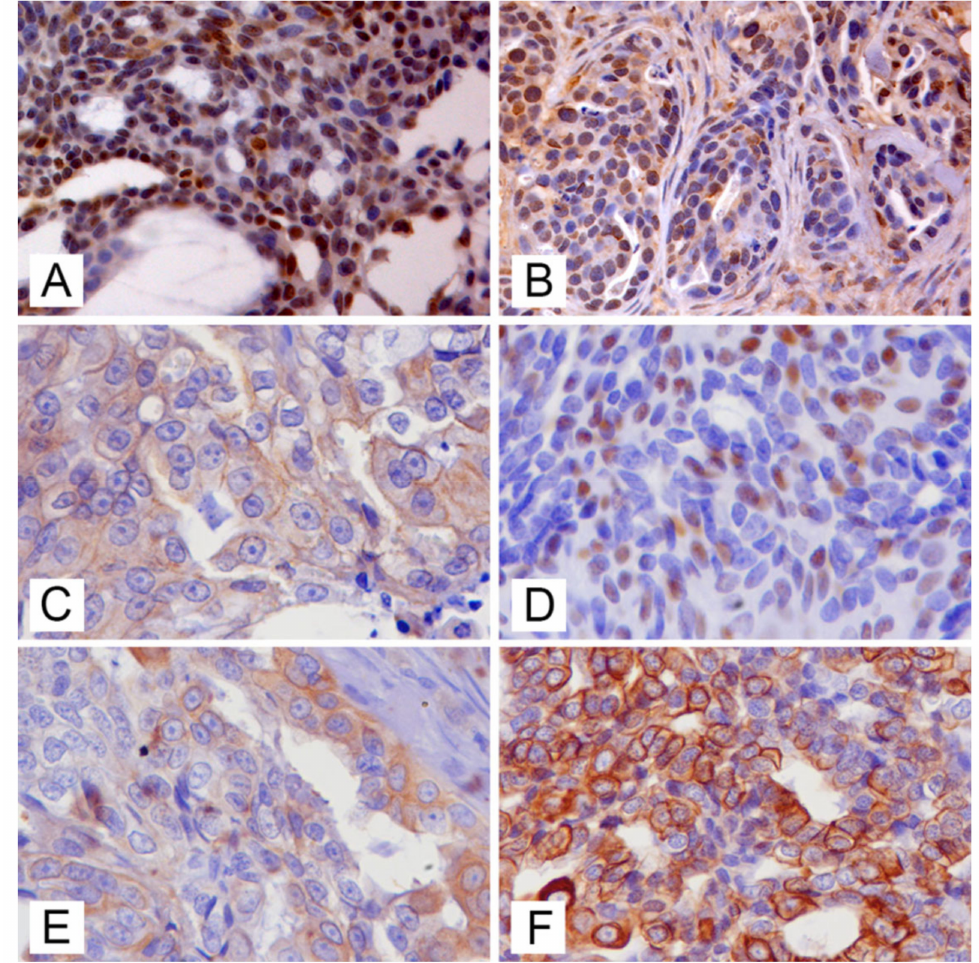
Figure 4. Feline mammary carcinomas (FMCs), immunohistochemistry for molecular phe- notyping: ( A ) nuclear labelling for anti-oestrogen receptor (OR) antibody in a OR+ FMC (bar = 50 µ m); ( B ) positive nuclear labelling for anti-progesterone receptor (PR) antibody in a PR+ FMC ((bar = 50 µ m); ( C ) immunolabelling of membrane for anti-c-erbB2 antibody in a 2+ c-erbB2 FMC (bar = 50 µ m); ( D ) nuclear immunolabelling for anti-p63 antibody in a p63+ FMC (bar = 50 µ m); ( E ) cytoplasmic immunolabelling for anti-cytokeratin (CK) 5/6 in a CK5/6+ FMC (bar = 50 µ m); ( F ) cytoplasmic immunolabelling for anti-CK14 in a CK14+ FMC (bar = 50 µ m). Following the semi-quantitative scoring system and the algorithm for molecular classification, 51 tumours (50%) were classified as luminal-like, 44 as basal-like (43%), 7 as c-erbB-2 overexpressing (7%), and no cases were null-like. Of the nine MMTV-like positive samples, six were classified as basal-like, and three were classified as luminal-like. Detailed data about MMTV-like-positive FMCs are reported in Table